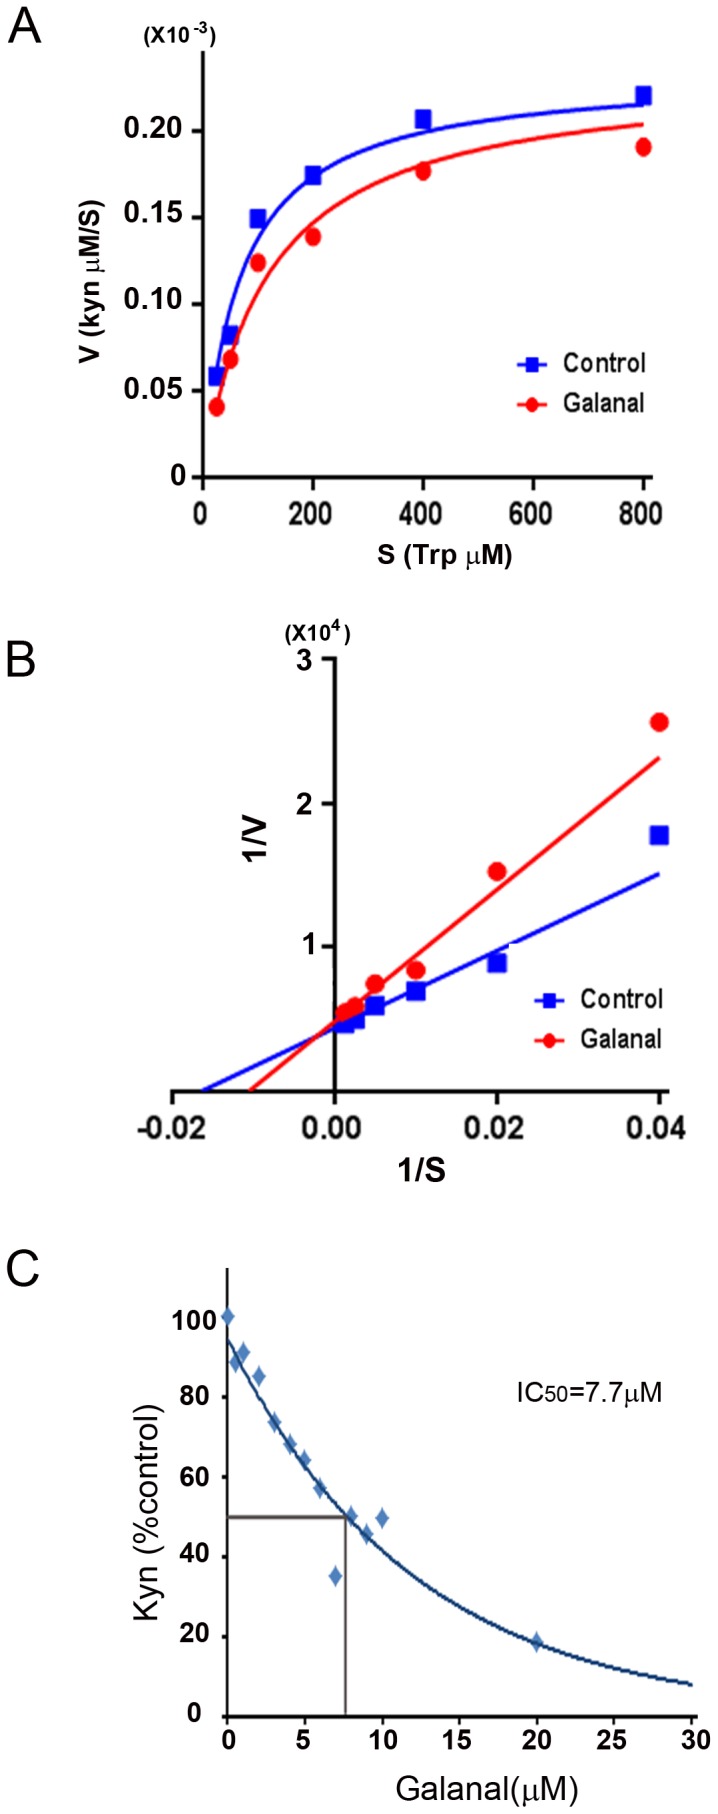
Kinetic analysis for enzymatic IDO1 inhibition by galanal and IC50 value of galanal.The mode of enzymatic IDO1 inhibition by galanal. The mode of the inhibition was analyzed using the (A) Michaelis-Menten model, or (B) the Lineweaver-Burk plot in the presence or absence of galanal. (C) The IC50 value of galanal for the enzymatic activity of IDO1.